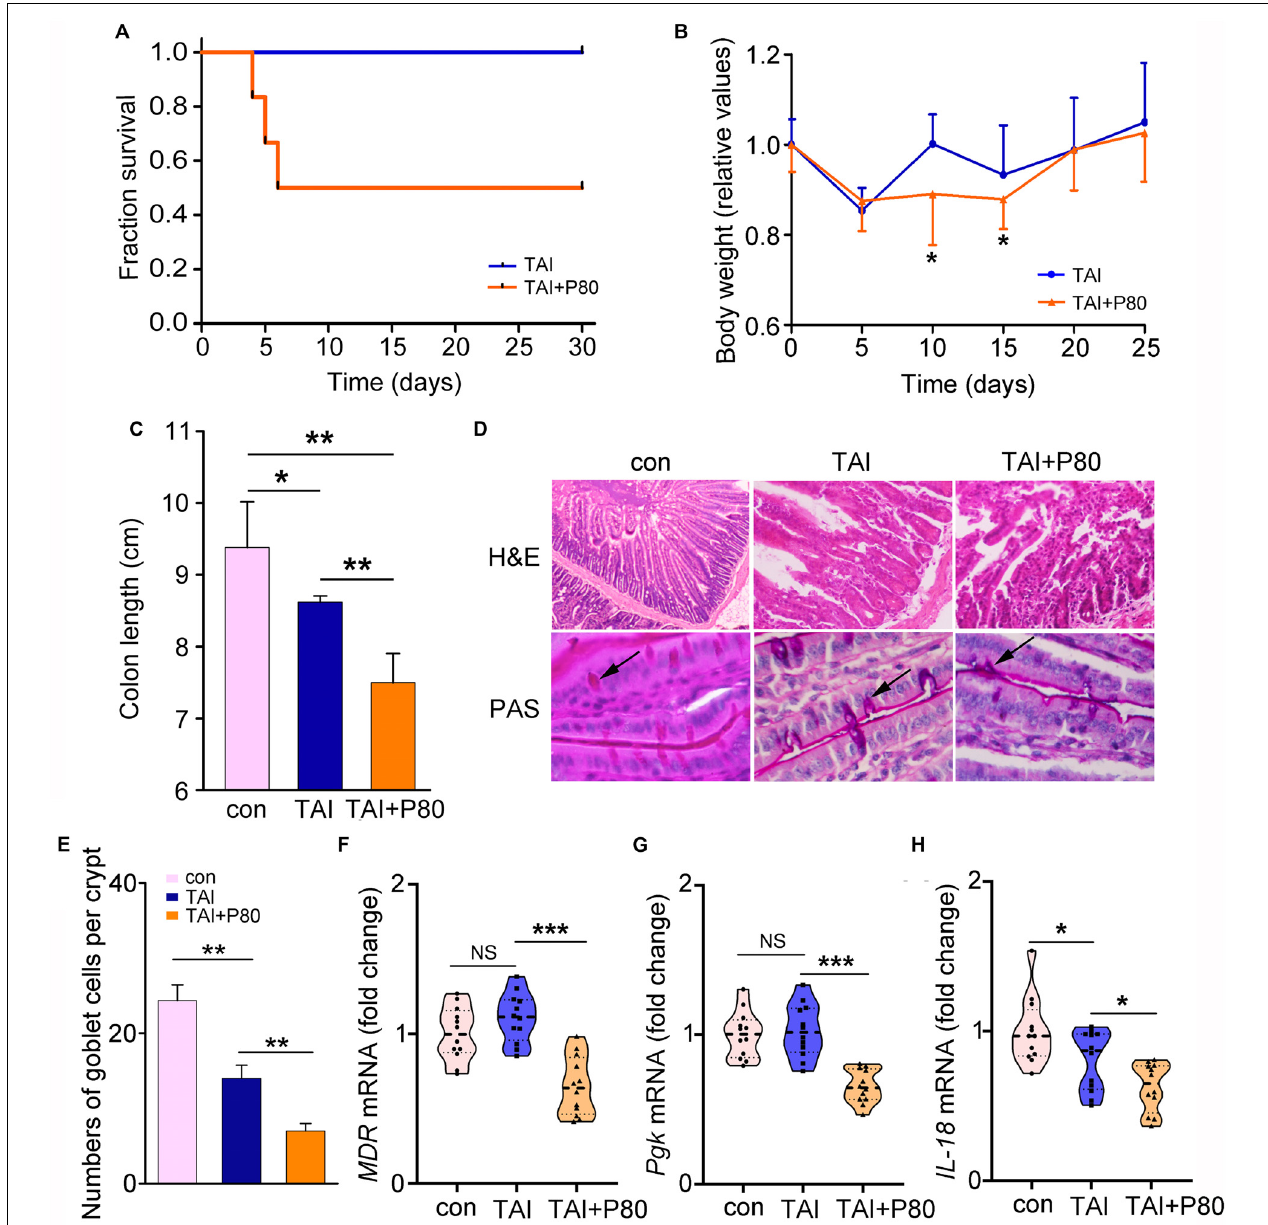
FIGURE 2 | P80 consumption aggravates RIII. (A) Mice received 7 days of oral gavage with water or P80 before TAI. Kaplan–Meier survival analysis was performed. p = 0.0028 by log-rank test, n = 12 per group. (B) The body weight was measured using two-way group ANOVA (* p < 0.05), n = 12 per group. (C) The length of colon tissues from irradiated mice was measured at 30 days after TAI. Statistically significant differences are indicated: * p < 0.05, ** p < 0.01; Student’s t -test, n = 12 per group. (D) The morphologies of the small intestines of mice were shown by HE and PAS staining. (E) The number of goblet cells per crypt was counted. Statistically significant differences are shown relative to the “TAI” group: ** p < 0.01; Student’s t -test between each two cohorts, n = 5 per group. (F–H) The expression levels of MDR (F) , Pgk (G) in small intestines and IL-18 (H) in colon tissues were examined by qRT-PCR. Significant differences are indicated: none significance (NS), * p < 0.05, *** p < 0.001; Student’s t -test, n = 12 per